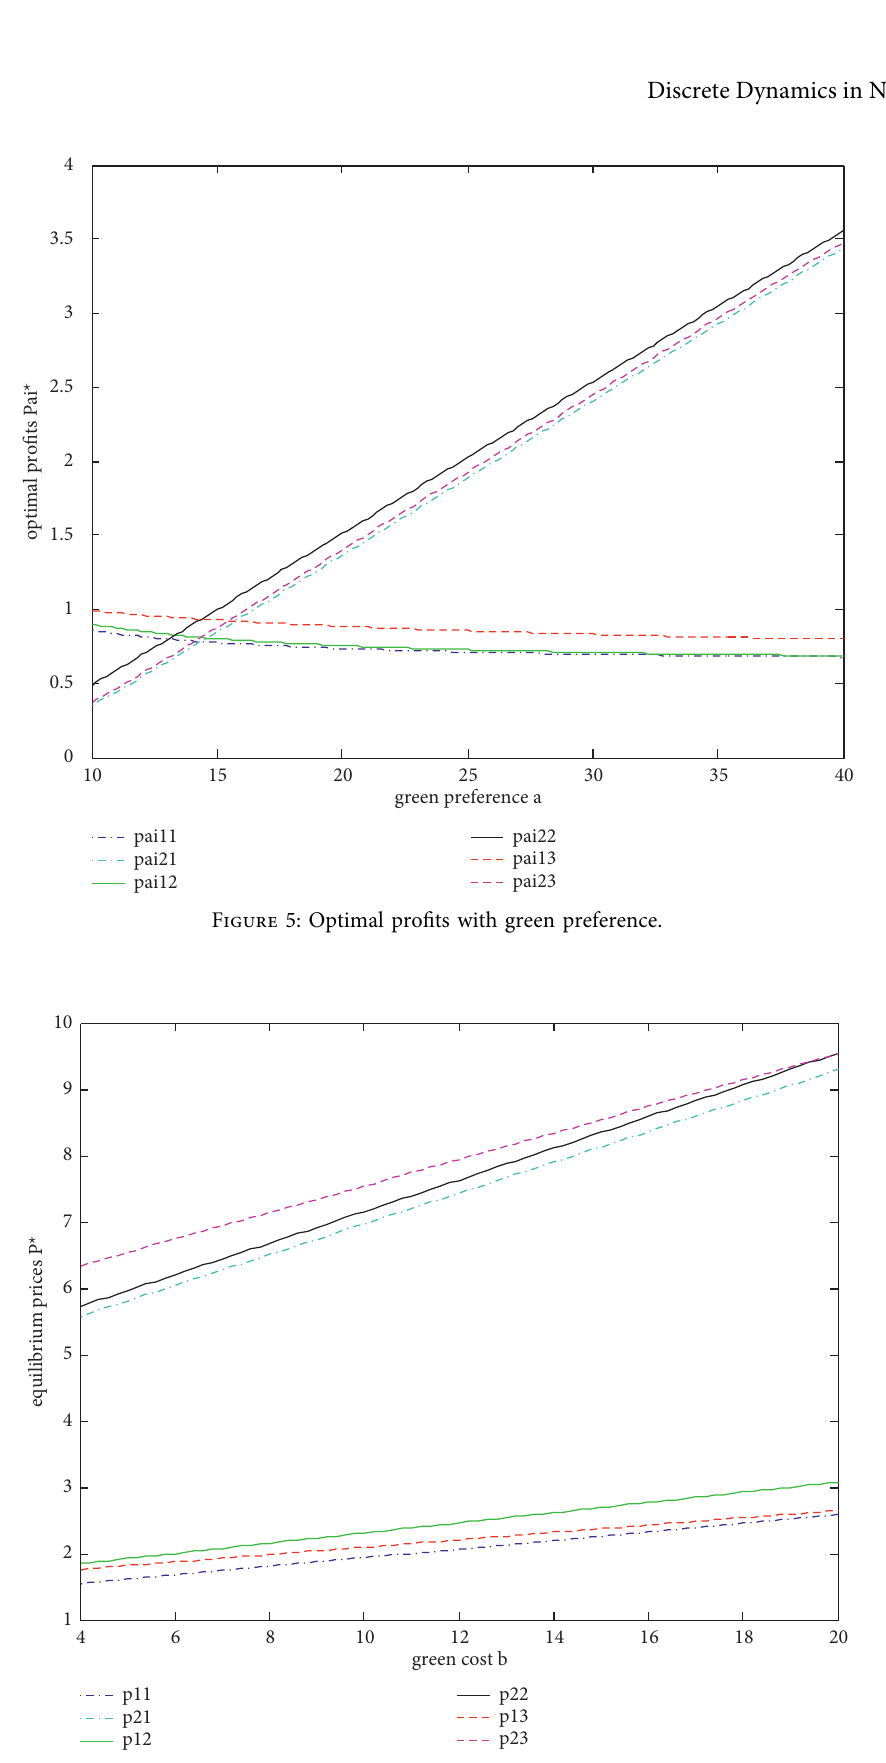
Figure 6: Equilibrium prices with green cost.